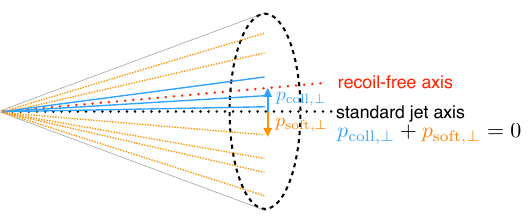
Figure 1 . The standard jet axis (black) is along the total jet momentum, making it sensitive to the recoil of soft radiation (orange). By contrast, a recoil-free axis (red) tracks the energetic collinear radiation